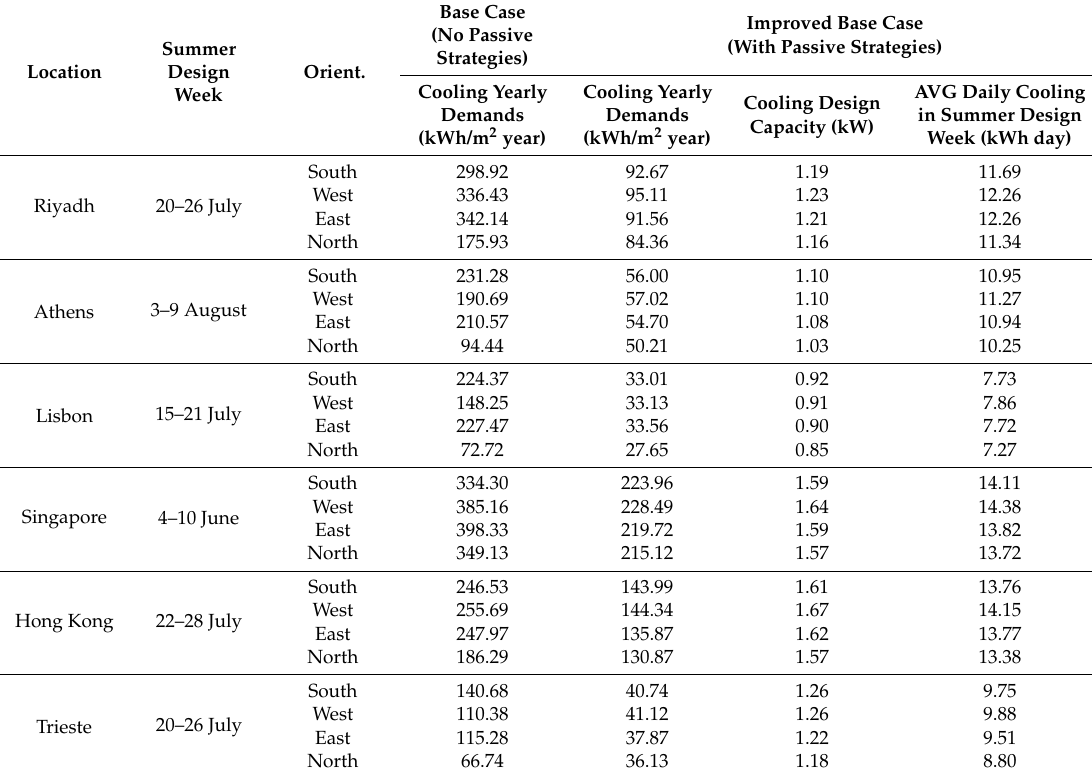
Table 3. Simulated cooling demands for all orientations and locations considered in the